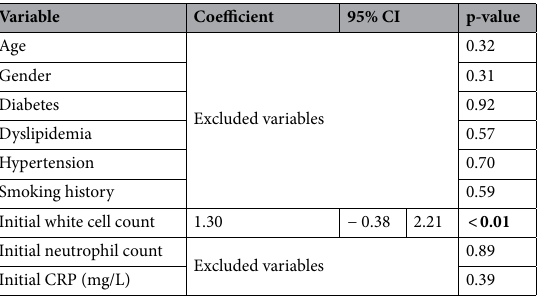
Table 3. Determinants of change of retinal venular calibre in cohort where final CRP < 100 mg/L. Results in bold where p <